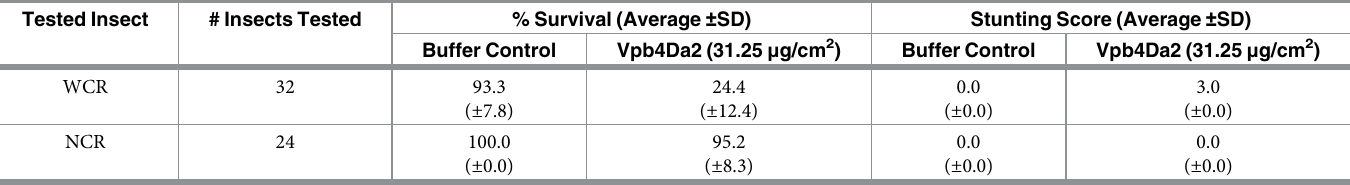
Table 1. Vpb4Da2 is highly active against Western corn rootworm but not Northern corn rootworm. Tested